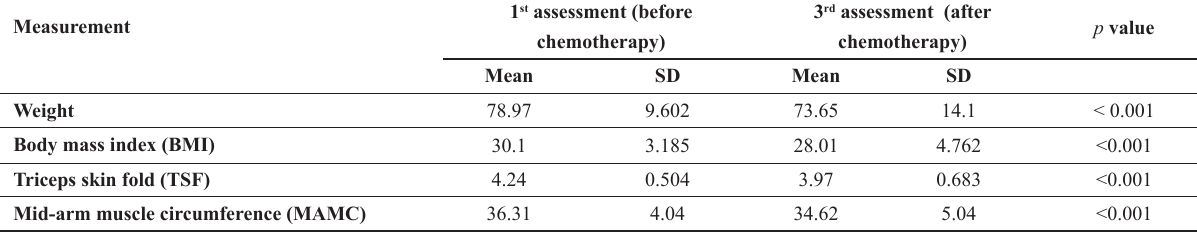
Table 4: Comparison of the anthropometric parameters before versus after chemotherapy